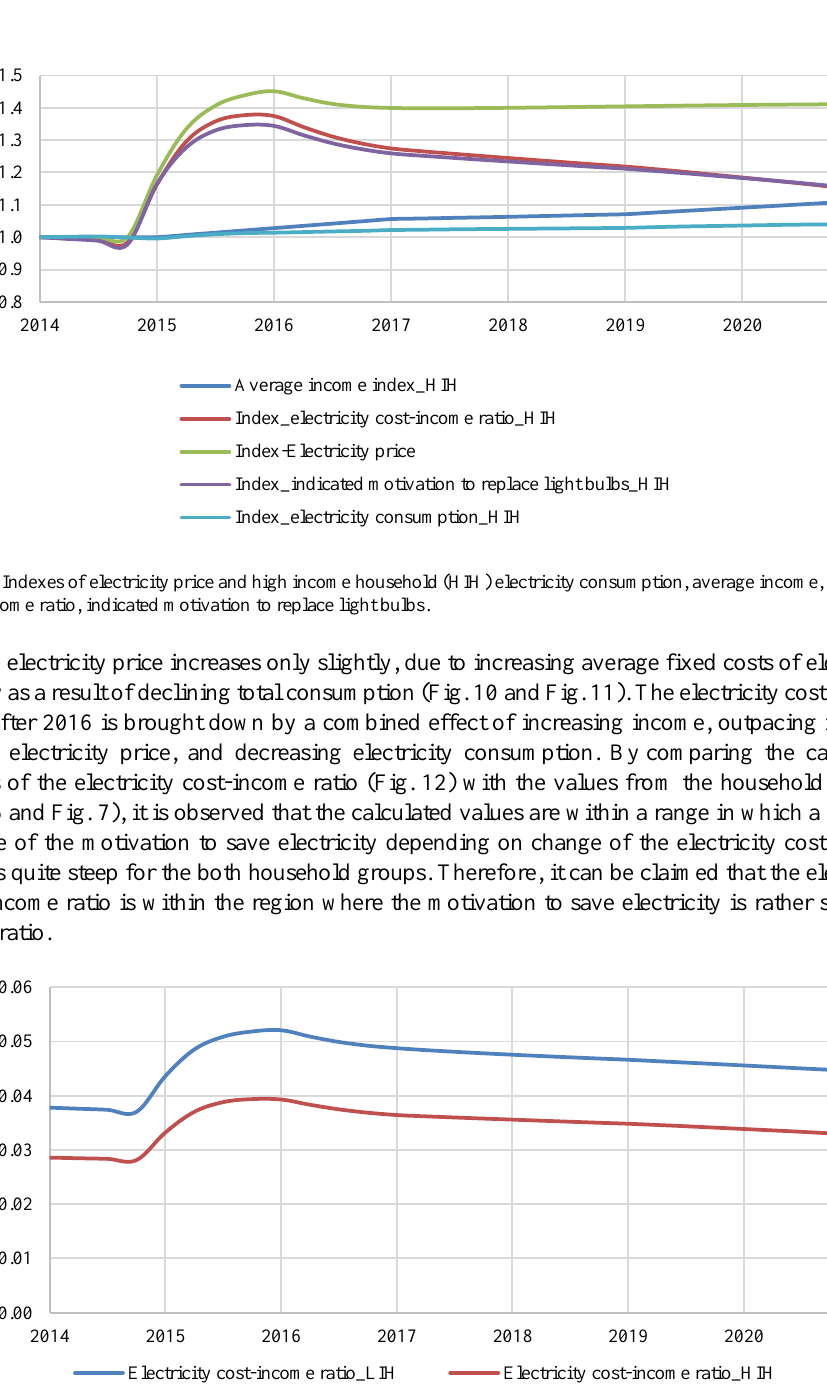
Fig. 12. Electricity cost-income ratios in low (LIH) and high (HIH) income